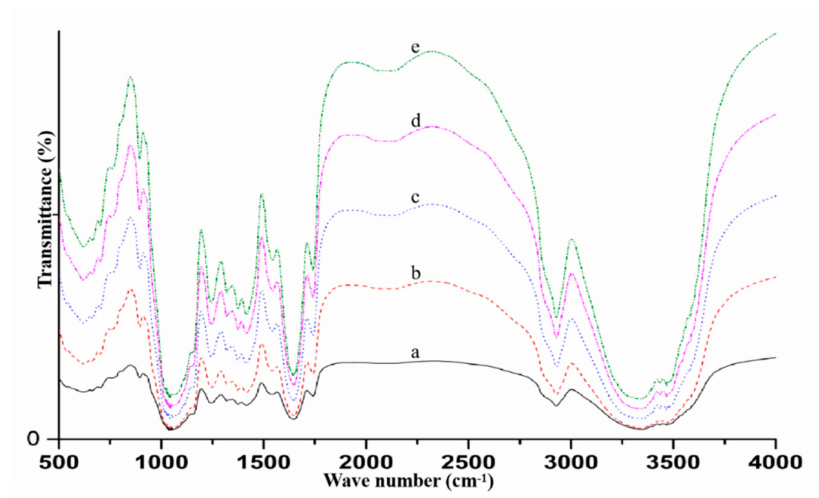
Figure 3. FT-IR spectra of ODF-SPI mixture ( a ) and ODF-SPI conjugates after dry heating at 60 ◦ C for 6 h ( b ), 12 h ( c ), 24 h ( d ) and 48 h ( e ).